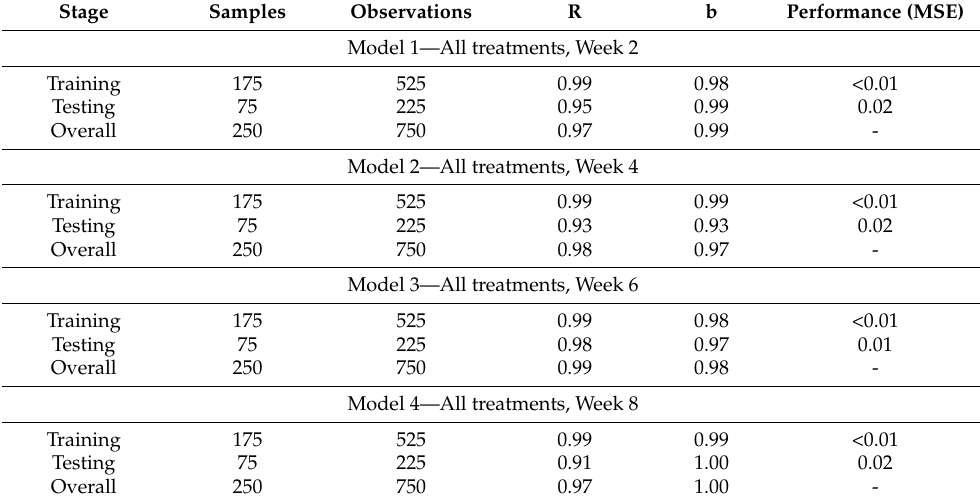
Table 2. Machine learning regression models based on artificial neural networks (Bayesian regular- ization) to predict plant physiological data using the electronic nose outputs as inputs; ten neurons were used. Abbreviations: R: correlation coefficient; b: slope; MSE: means squared error.